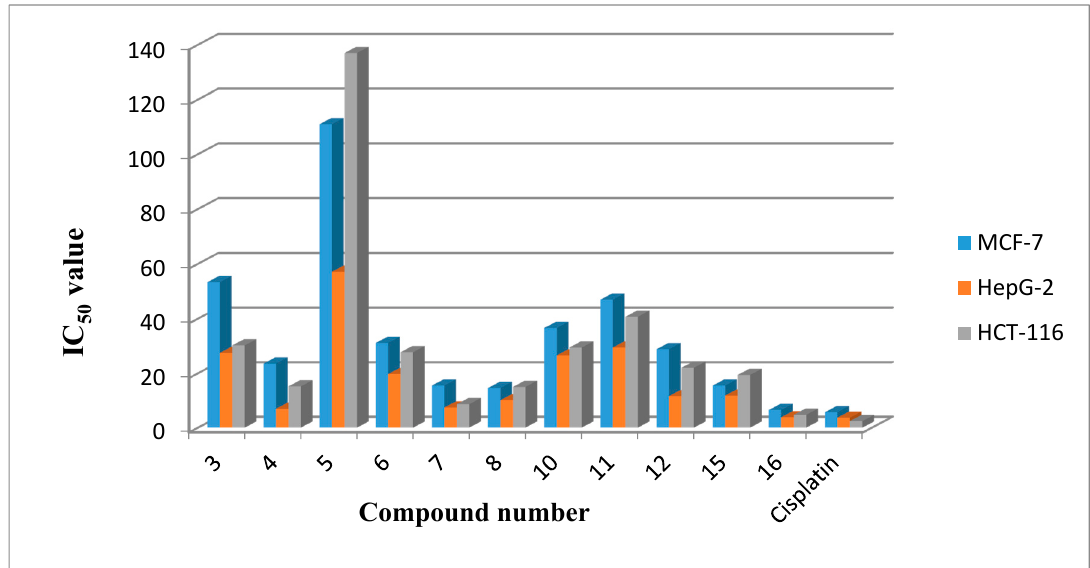
Figure 2. The antitumor activities of the tested compounds expressed as IC 50 values and compared with reference standard drugs evaluated on breast, liver cancer and colon carcinoma cell lines.